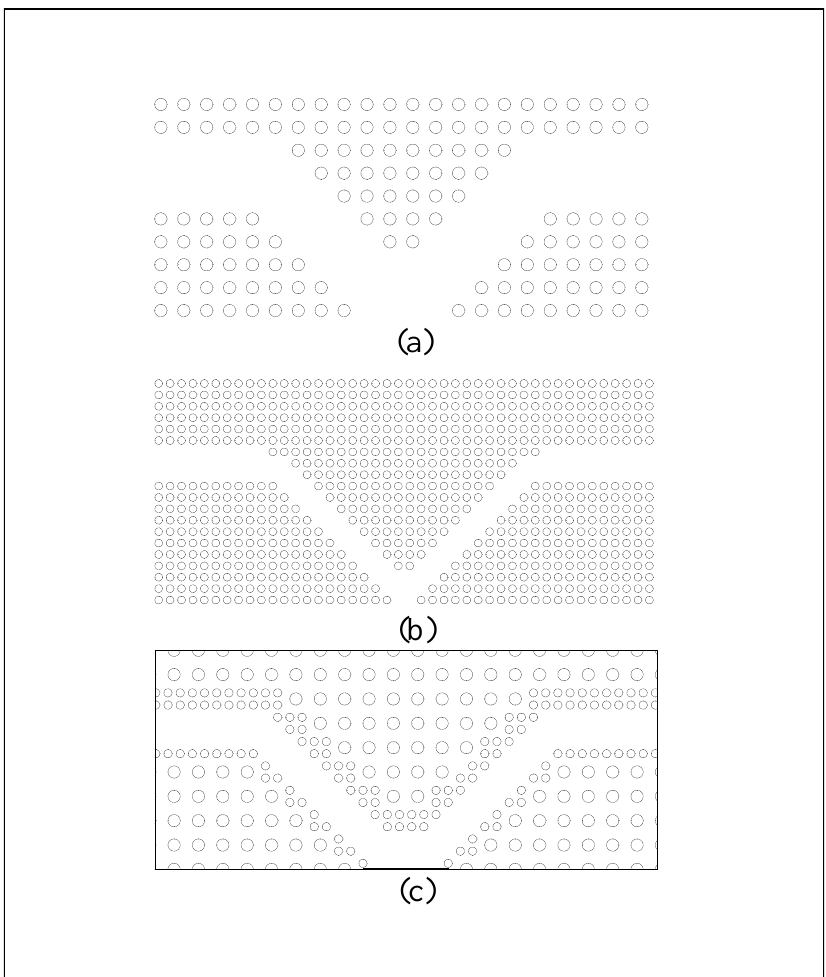
Figure 2. ( a ) The PhC structure with r and d specifications larger than that of structure ( b ) is used to fill space, achieve better confinement, and due to its dimensions, has a more simple manufacturing process. ( b ) The PhC structure with r and d specifications smaller than that of structure ( a ) is used for better wave propagation and for adjusting the incident angle of the wave with the electronic section. ( c ) The hybrid structure of ( a , b ) is used in the optical section of